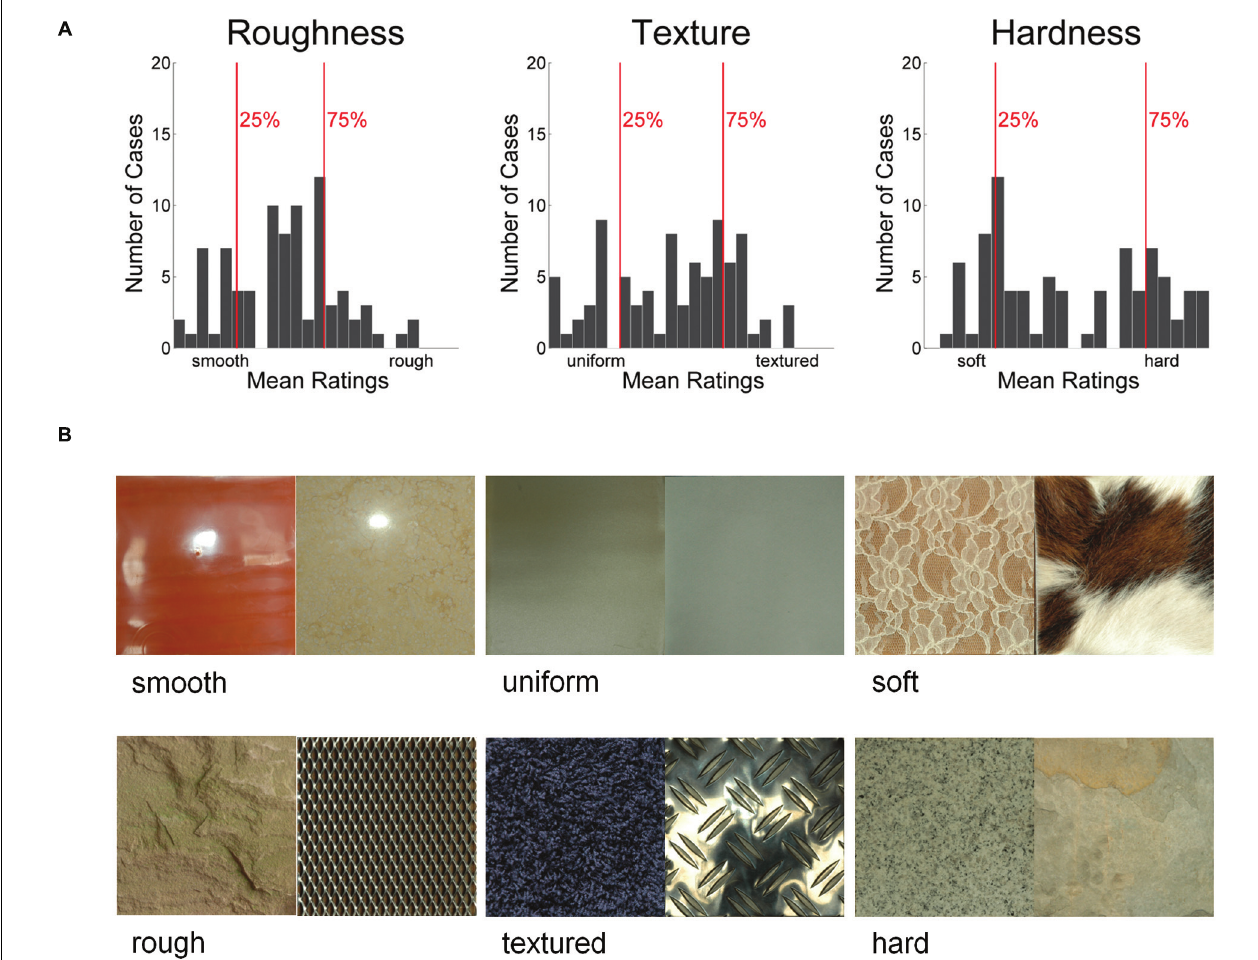
FIGURE 2 | Rating distributions (average ratings of six observers) for all 84 images for each of the three material properties (A) and example images (B). Vertical red lines indicate the 25th and 75th percentile of ratings. Images with ratings below the 25th percentile made up the low-rating images for that property, and images above the 75th percentile made up the high-rating images. The cutoffs were at 2.3 and 4.2 for roughness, at 2.5 and 4.7 for texture, and at 2.5 and 5.7 for